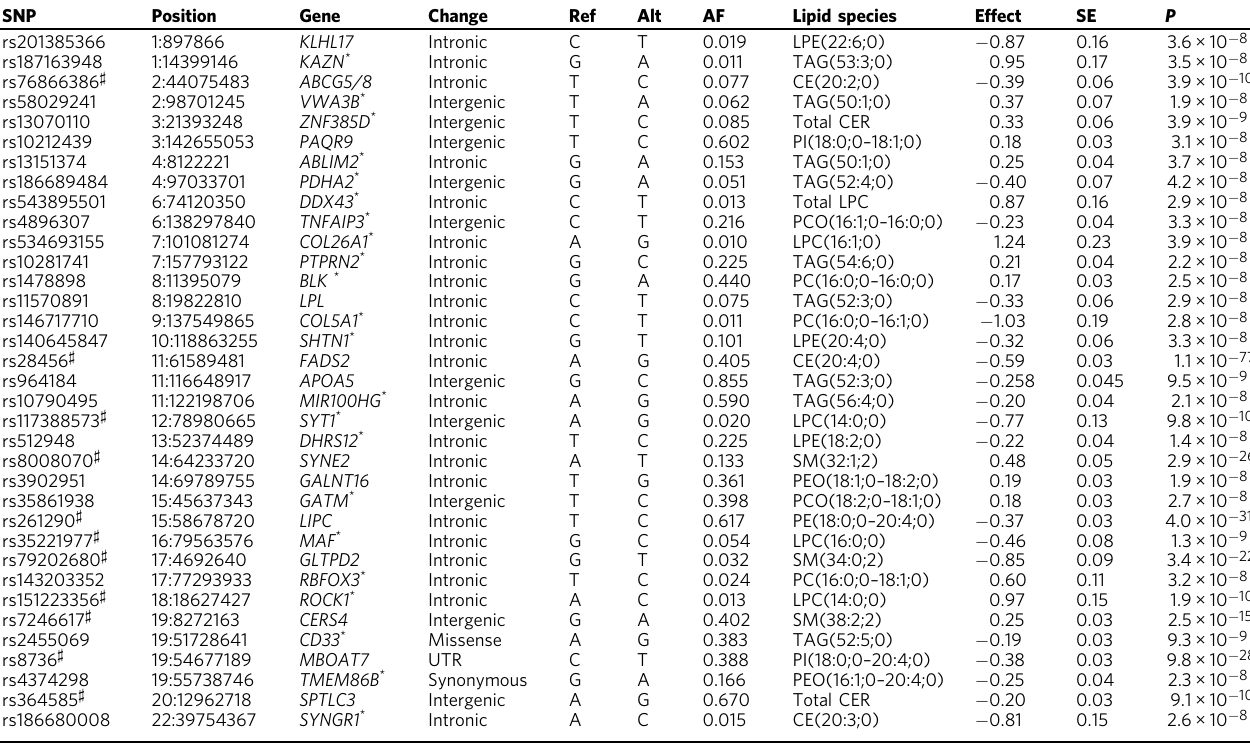
Table 1 Genomic loci associated with molecular lipid species at genome-wide signi fi cance